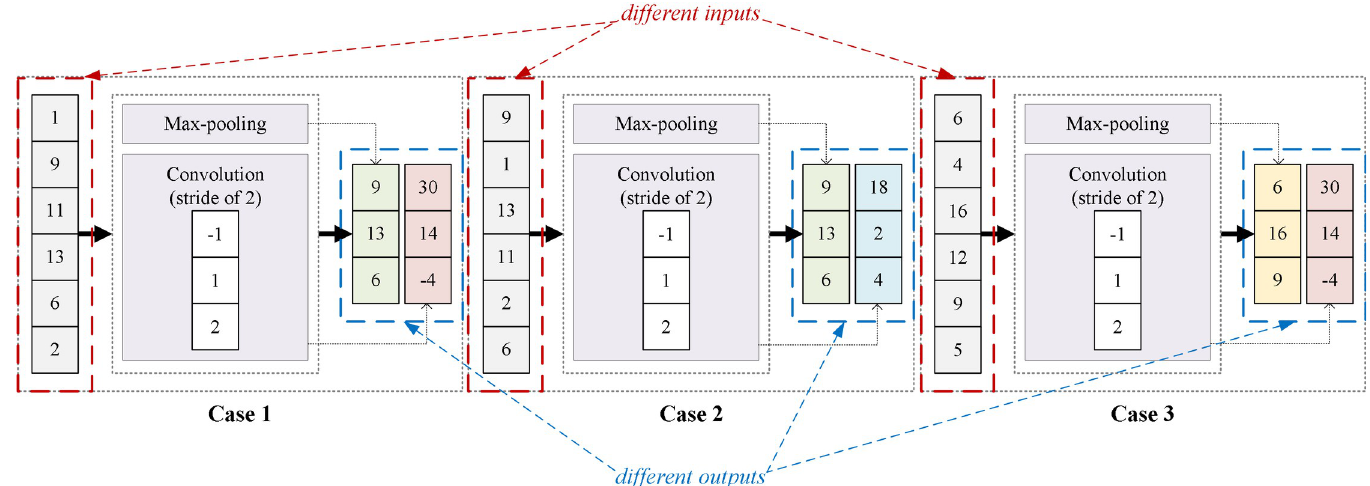
Fig 3. The procedure of the CFF strategy. Both the max-pooling and the 2-stride convolution are applied to the inputs. After doing so, distinguishable features are obtained to represent different sequential data.